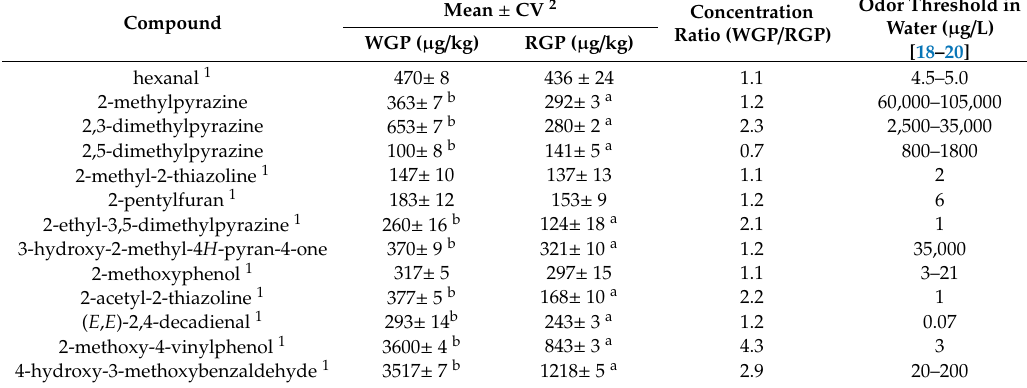
Table 2. Concentration of aroma compounds in extruded maize refined grain pu ff s (RGP) and whole grain pu ff s